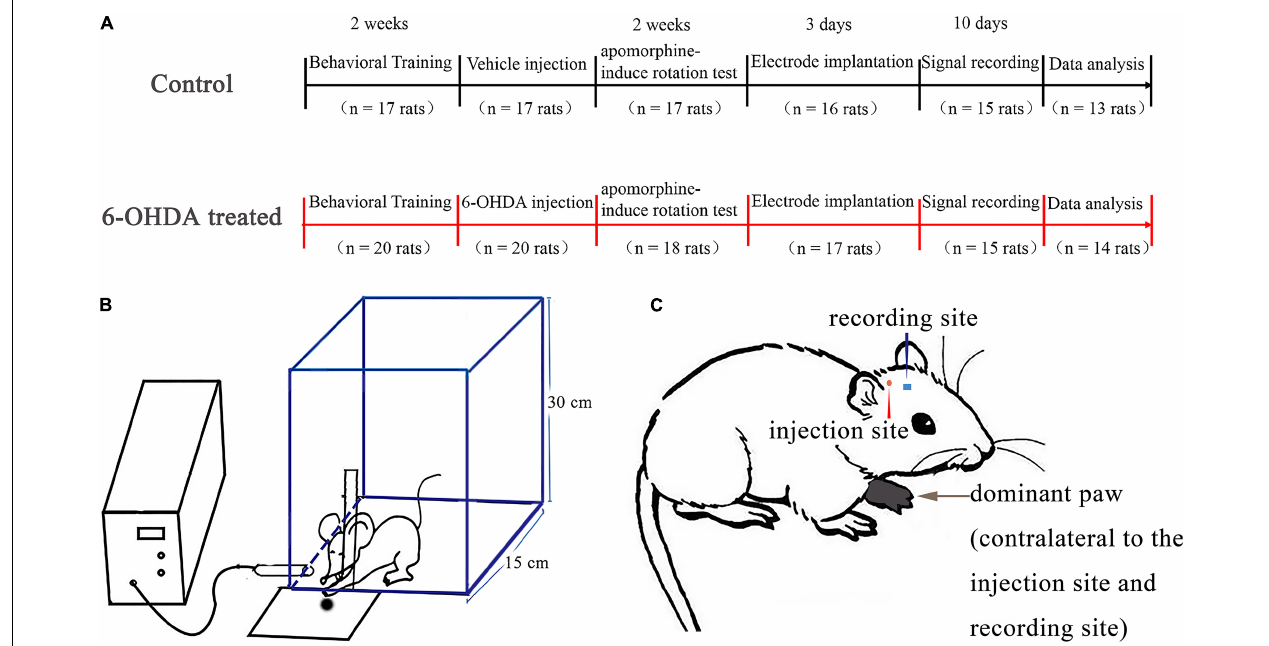
FIGURE 1 | Experimental timeline and design. In all experiments, all rats ( n = 37) underwent behavioral training and monitoring in a rectangle transparent Plexiglas box and the most frequently used paw was determined as dominant paw. After 14 days, one group (6-OHDA-treated, n = 20 rats) was given a unilateral 6-OHDA treated in the medial forebrain bundle (MFB) of the hemisphere contralateral to the dominant paw, the other group (control, n = 17 rats) was given saline. After 14 days, lesion efficacy was tested by apomorphine-induced rotation test. Rats from the first group (6-OHDA-treated, n = 14 rats) with successful lesioned effects and the second group (control, n = 13 rats) underwent surgery to implant recording electrodes in the motor cortex of the same hemisphere as the injection side. Signal recording began 3 days after the electrodes were implanted. Rats were placed in the reaching box in order to record the neuronal activity at both rest and reaching periods. (A) Illustration of the self-made chamber design to reach for food pellets. Test chamber used to assess trained reaching to catch food, and this schematic shows that the rat could reach through a slot to make contact with food from the tray. This reach would simultaneously create a mark on the computer via the infrared obstacle avoidance sensor attached to the chamber front wall (B) . A rat showing naming conventions. This example is a rat whose left paw dominates after food reaching training. Intracerebral injections of the vehicle or 6-OHDA (in MFB) and recording electrode (in M1) are contralateral to the dominant paw (C) .